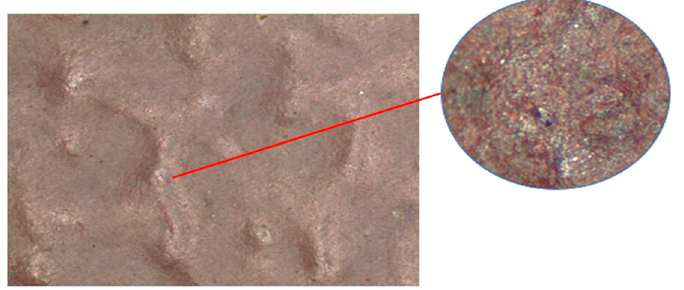
Figure 16. No rust spot or cracks on the surface of the no-WBM specimen with a primer thickness of 80–170 μ m.